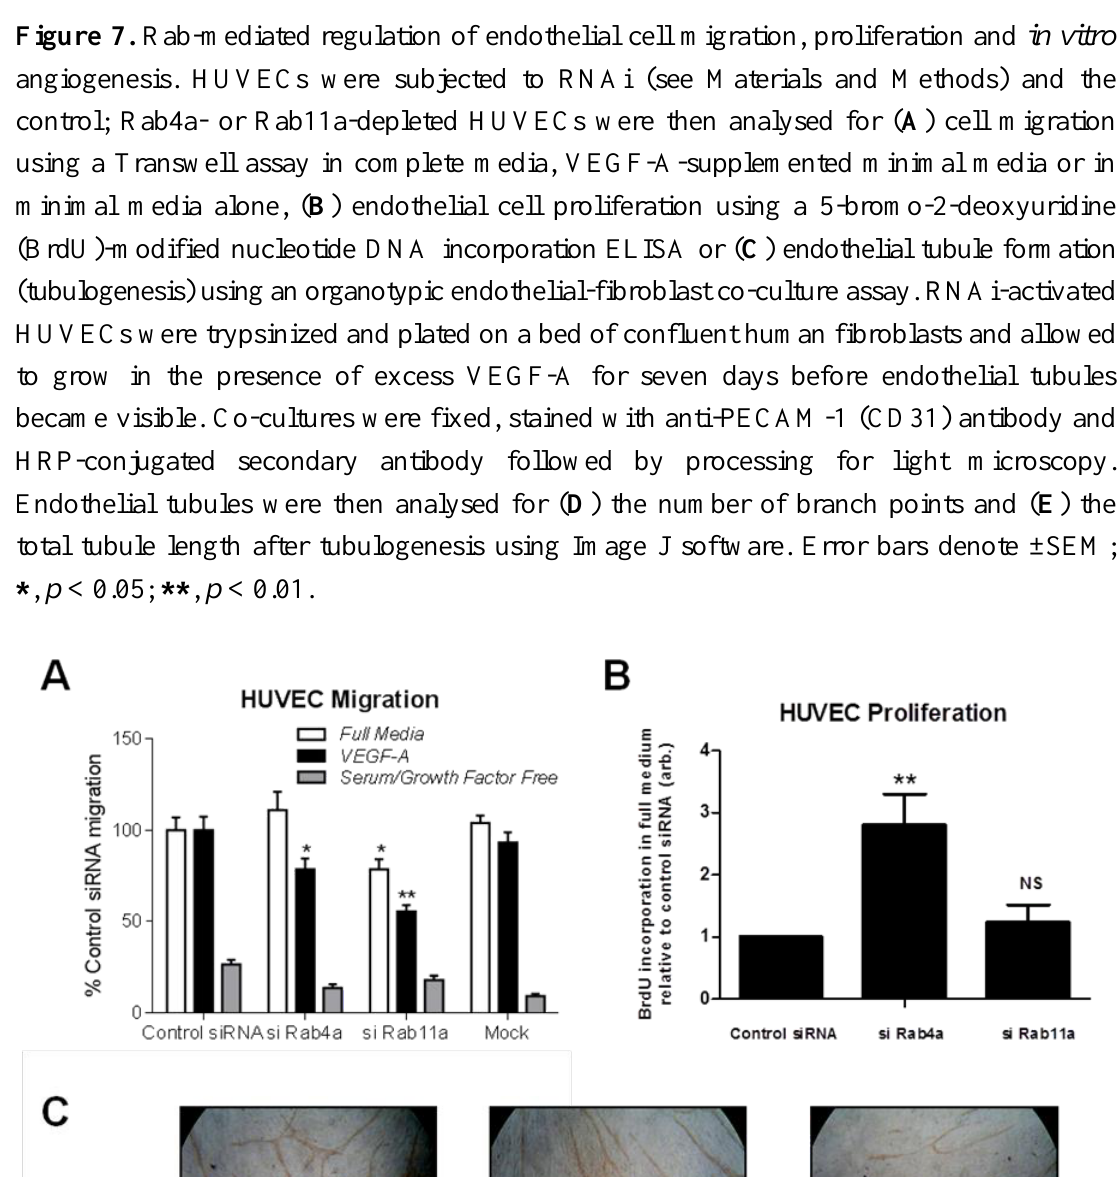
Figure 7. Rab-mediated regulation of endothelial cell migration, proliferation and in